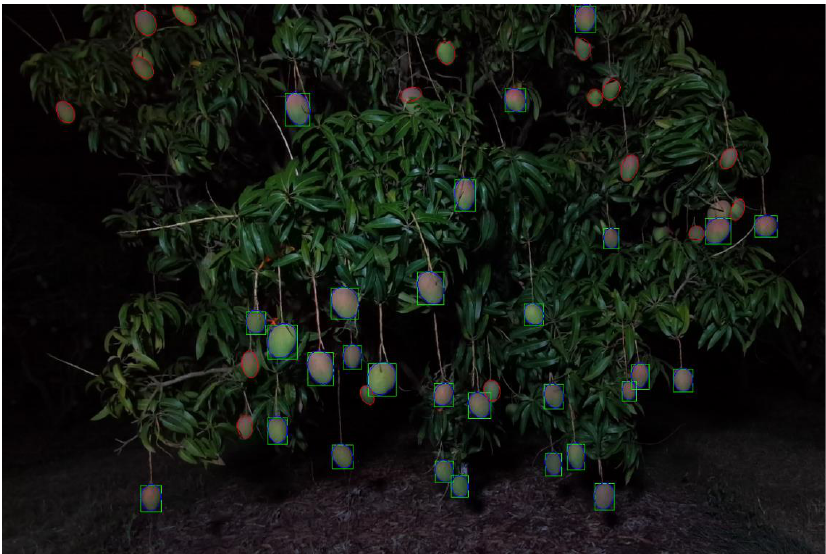
Figure 7. Method 3 – Mask R-CNN segmentation within YOLOv4-tiny detected bounding boxes.